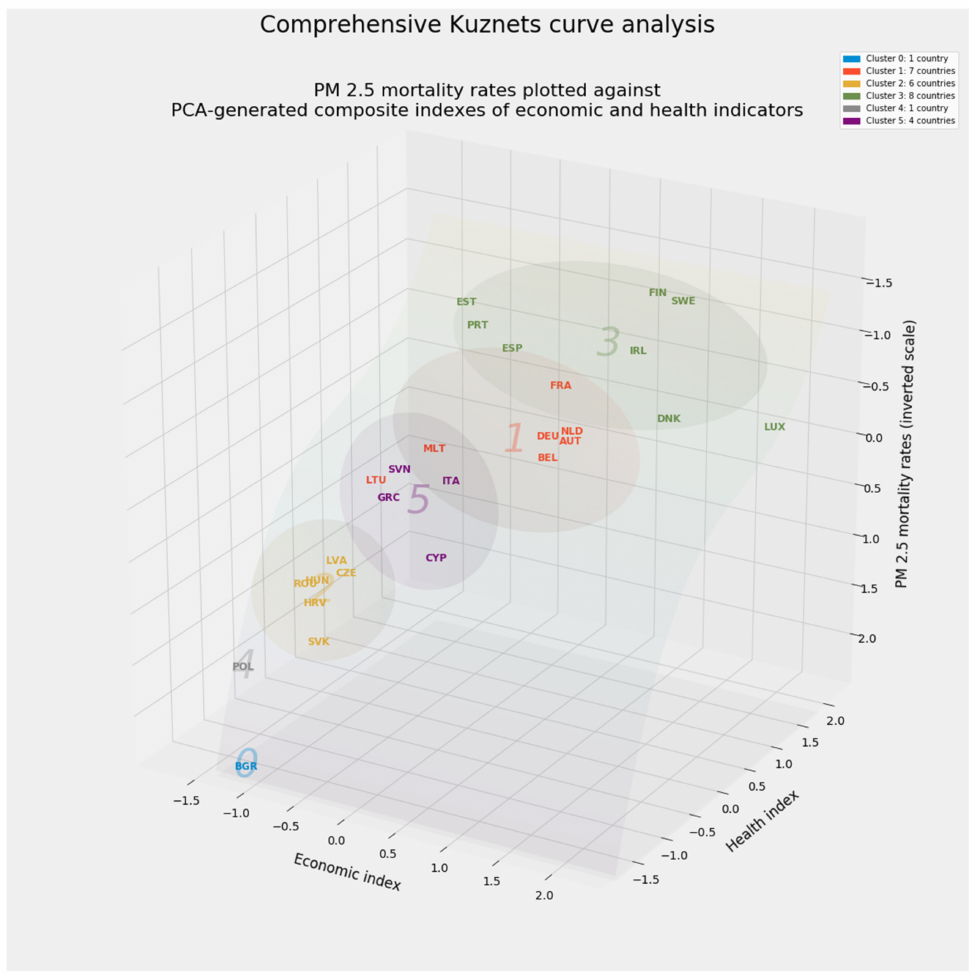
Figure 18. A comprehensive environmental Kuznets curve plotting PM 2.5 mortality rates against PCA-generated composite economic and health-based